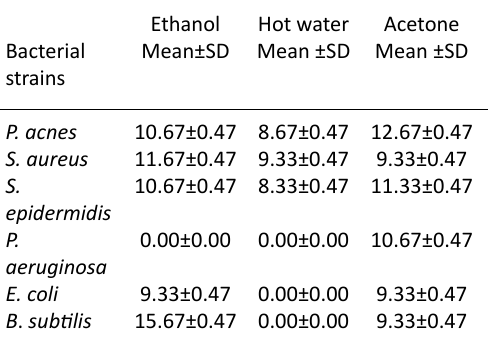
Table 2. Screening of antibacterial susceptibility of Azadirachta indica extracts using three different solvents against bacterial isolates